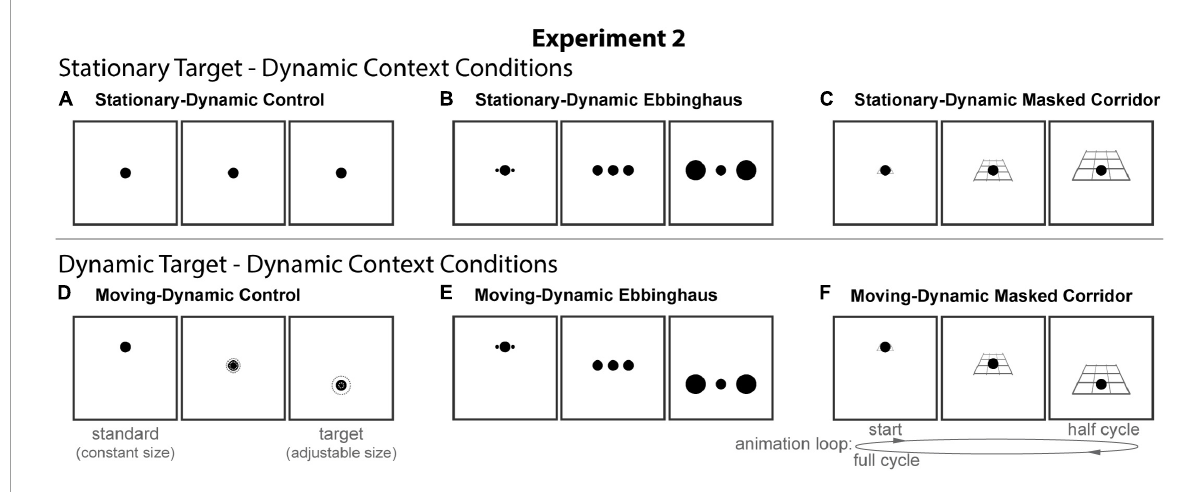
FIGURE4 The six conditions of Experiment 2. Columns represent the three distinct contexts [Control (A,D) , Ebbinghaus (B,E) , Masked Corridor (C,F) ]. Rows represent the two configurations [Stationary-Dynamic (A–C) and Moving-Dynamic (D–F) ]. For each condition, screenshots for the beginning (standard circle), middle, and end (target circle) frames are shown. The animation [as labeled in panel (F) ] played in a continuous loop. In the figure, the circle is the same physical size in all frames; during the experiment, the target (lower right circle for Static conditions or the far-right frame for Dynamic conditions) was adjusted by the participant [see panel (D) ]. Here, stimuli are cropped to display the central portion of the screen to save space. Supplementary Video 2 showing all of the dynamic conditions for Experiment 2 can be found in the Supplementary materials (best viewed in “loop”